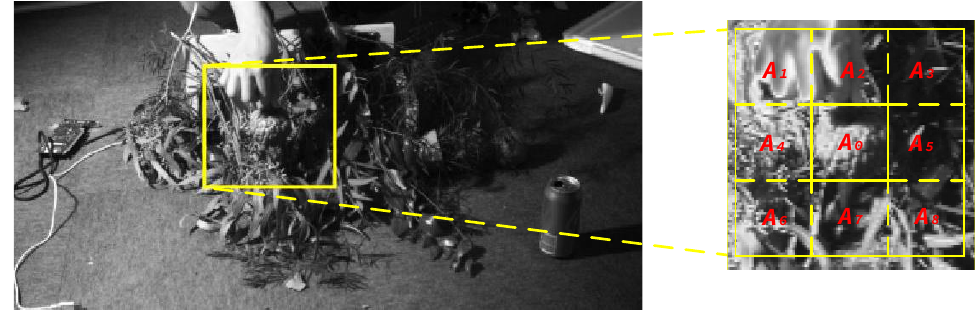
Figure 8. Contextual sampling area